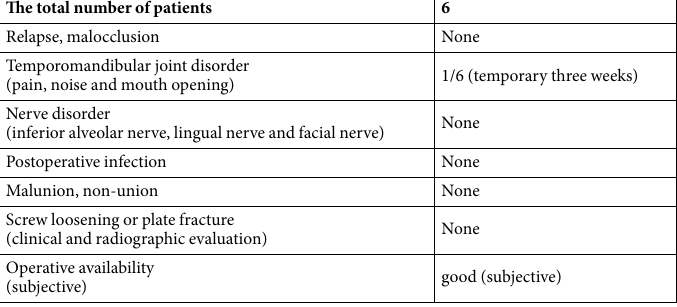
YK-plate and Surgical Technique.